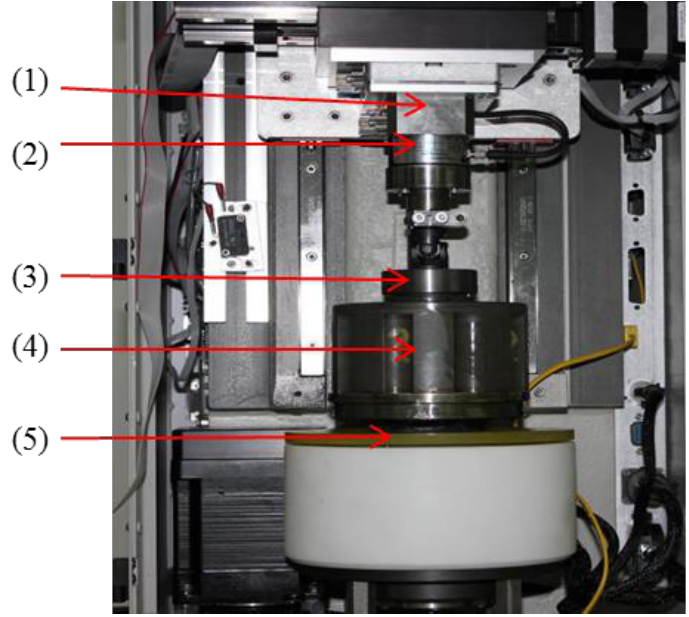
Figure 24. Friction coefficient test of port plate pair on CETR UMT-3 (1) pin holder, (2) force sensor,